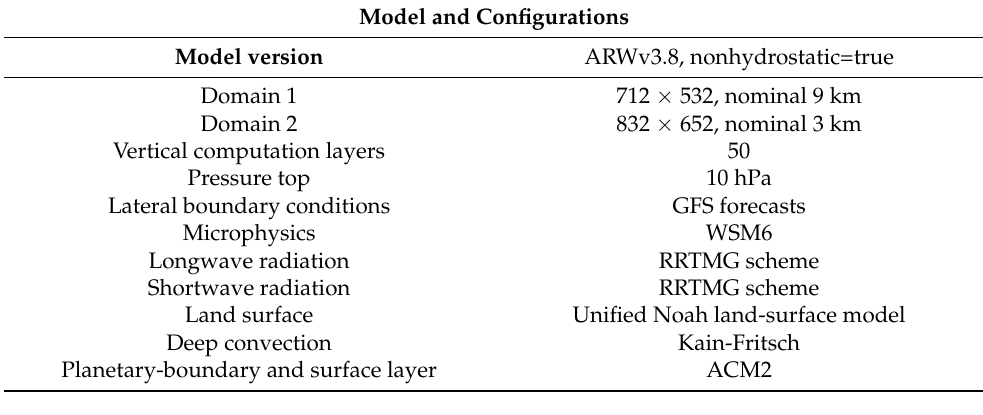
Table 1. Experimental configurations of WRF model.